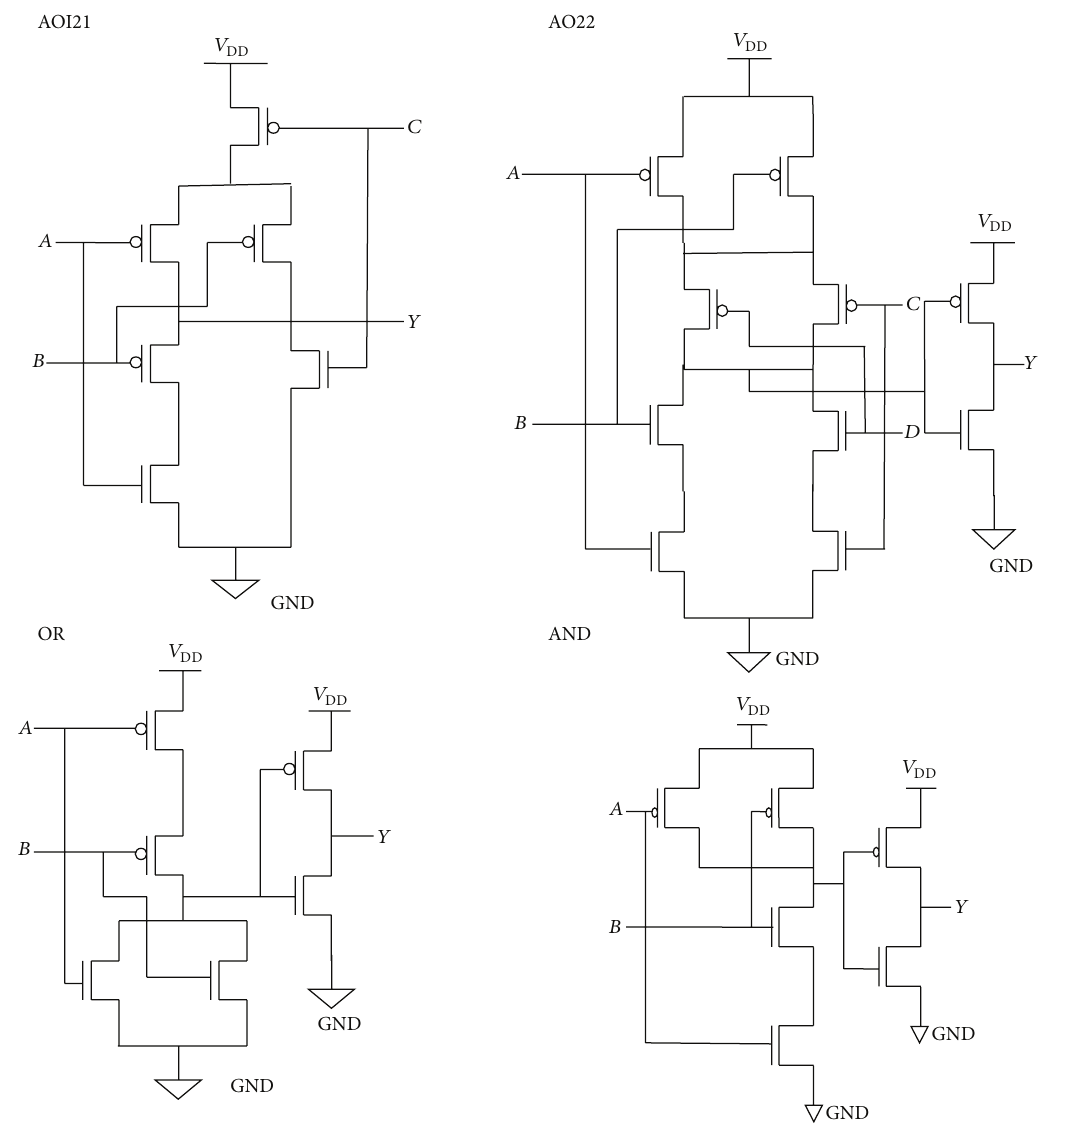
Figure 4: Transistor stack example of logic